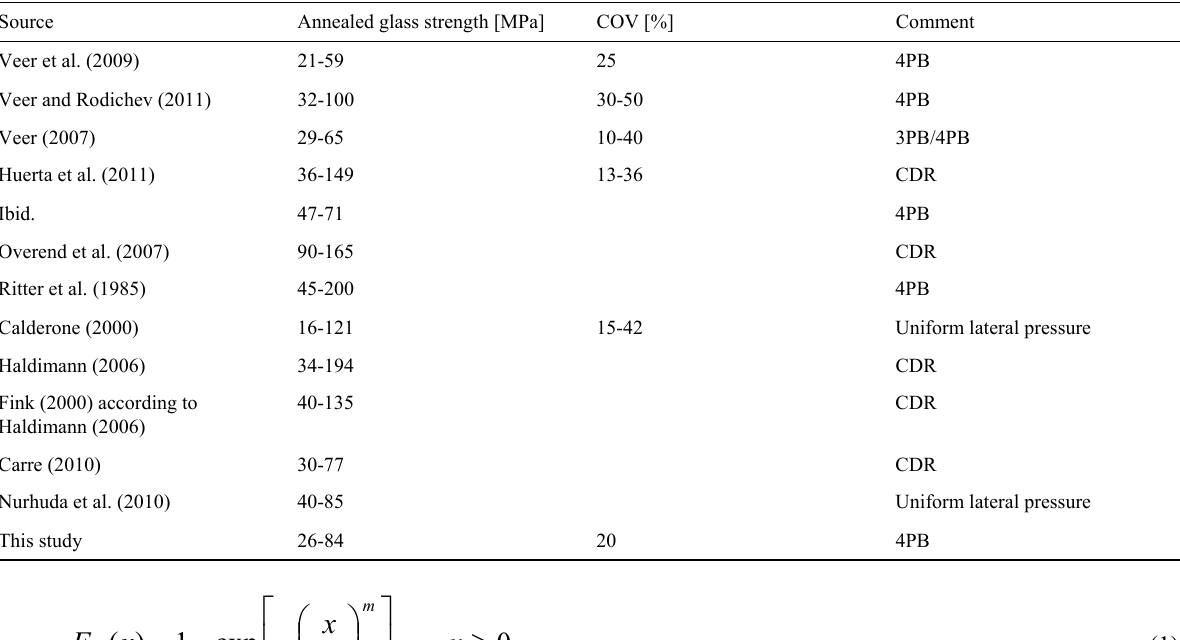
Table 1: Range of values for the apparent strength of